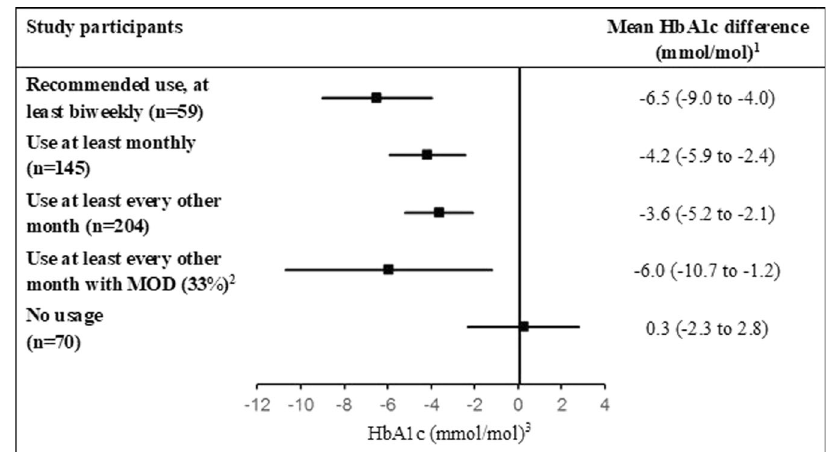
Fig. 2 Change of HbA1c from baseline to end of follow-up in study participants at different usage patterns compared with controls. 1 Estimated differences of study participants minus matched controls are presented as means (95% CI). 2 Change of HbA1c when the tool was used at least every other month in participants with MOD characteristics compared with matched controls with MOD. A total of 32%, 28%, 33% and 21% of participants using the tool at least biweekly, monthly, bimonthly, and non-users, respectively, had MOD. 3 Plots of mean HbA1c difference between participants and controls with 95% con fi dence